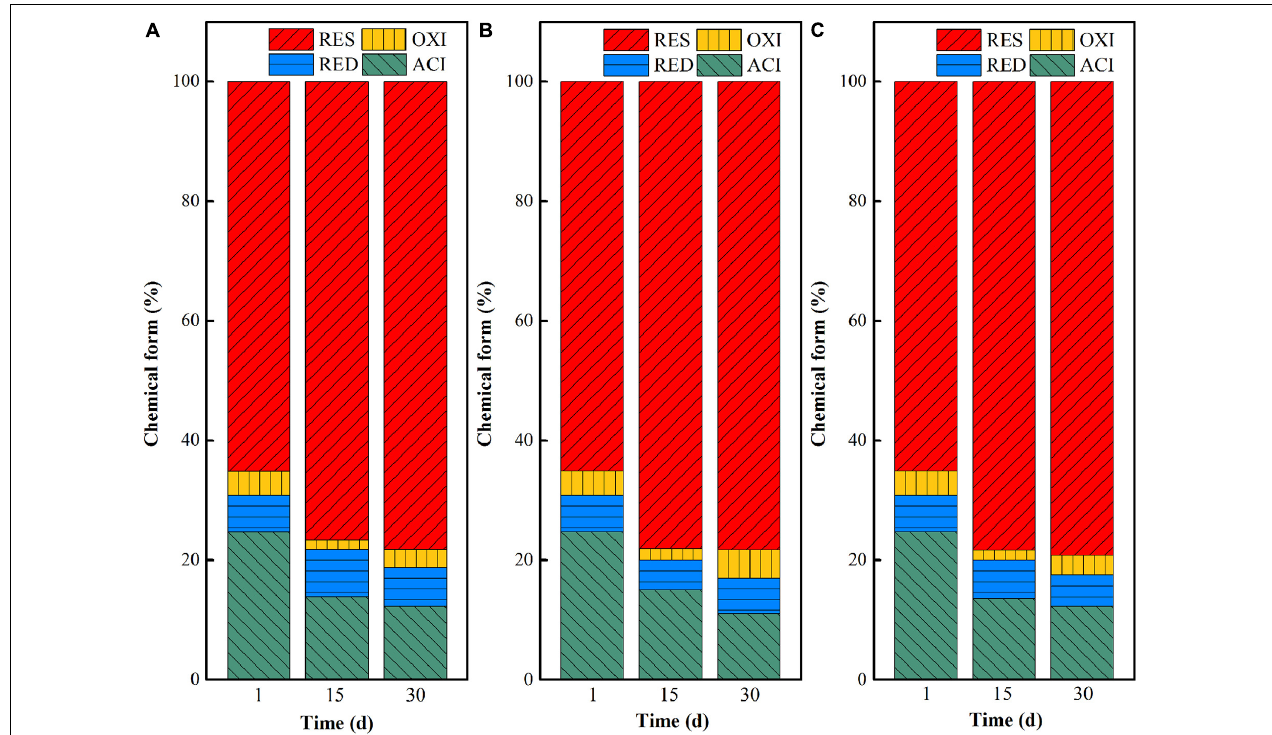
FIGURE 8 | Chemical form changes of uranium in uranium tailings under different temperatures, (A) I-5; (B) I-10; and (C) I-20.